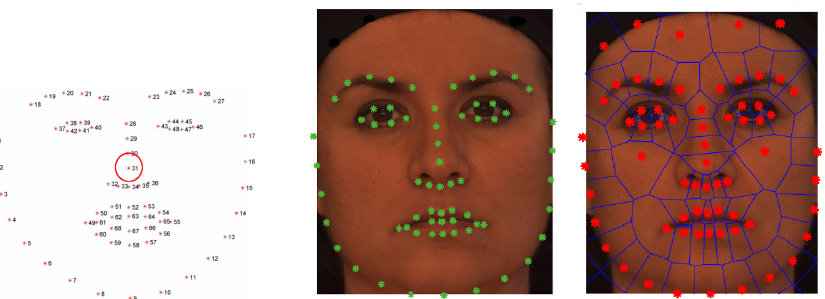
Figure 6. Estimated facial landmarks ( left ), landmarks on the face ( center ) and the Voronoi Diagram ( right